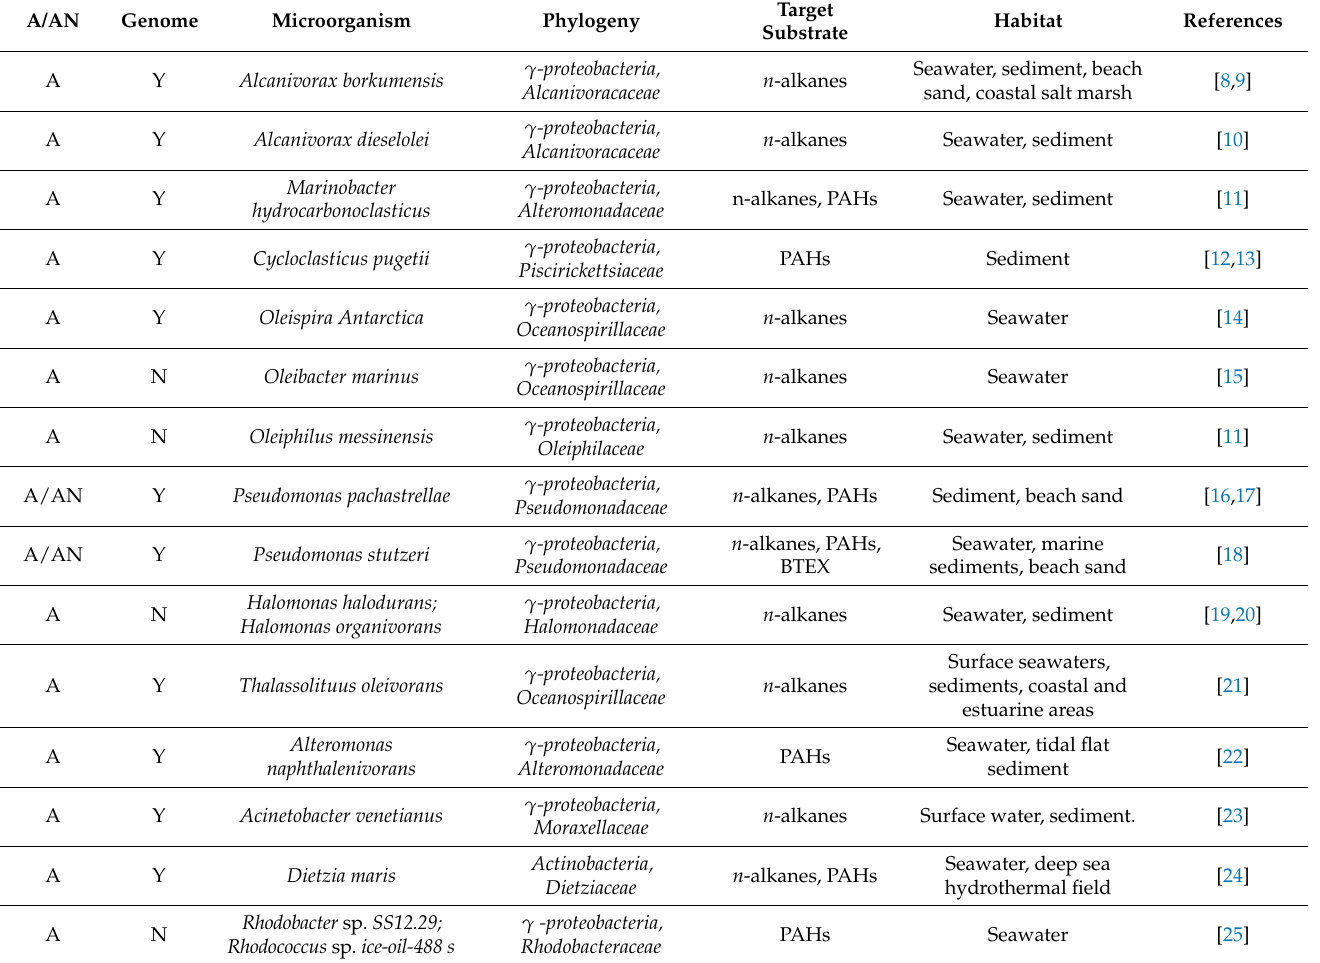
Table 1. The list of investigated HCs-degrading microbial strains with their ecological and phylogeny